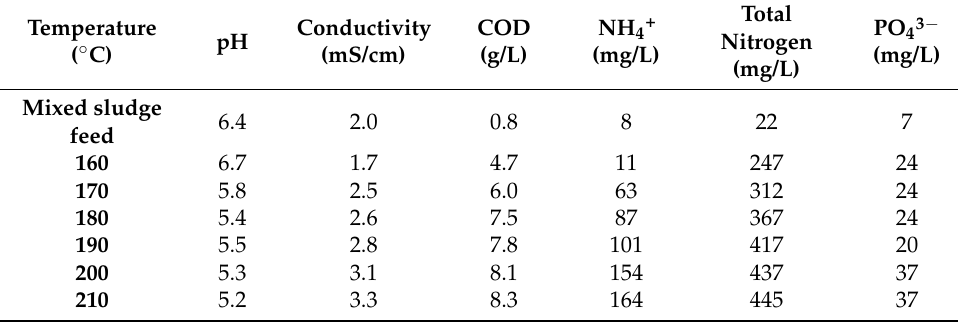
Table 2. Characteristics of the mixed sludge feedstock before and after processing, and the effect of hydrothermal treatment reaction temperature. Reported values for COD, NH 4+ , total nitrogen and PO 43 − correspond to the dissolved